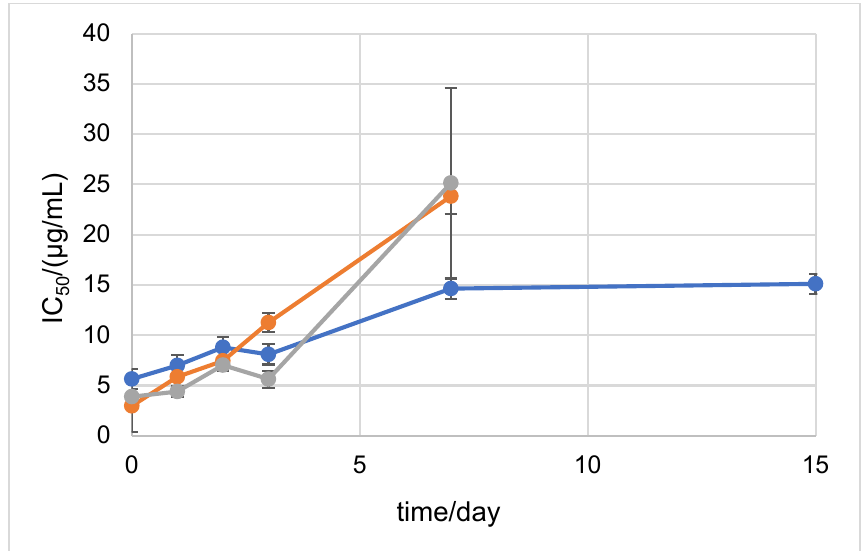
Figure 5. ABTS antioxidant stability of AA, NH 2 AA (D1), and CH 3 NHAA (D2) after 0, 1, 2, 3, 7, and 15 days of incubation at +4 °C in the dark (after 15 days, all constituents decomposed). Results are expressed as µg/mL ± standard deviation (SD). D1 is shown in orange, D2 in blue, and AA in gray.